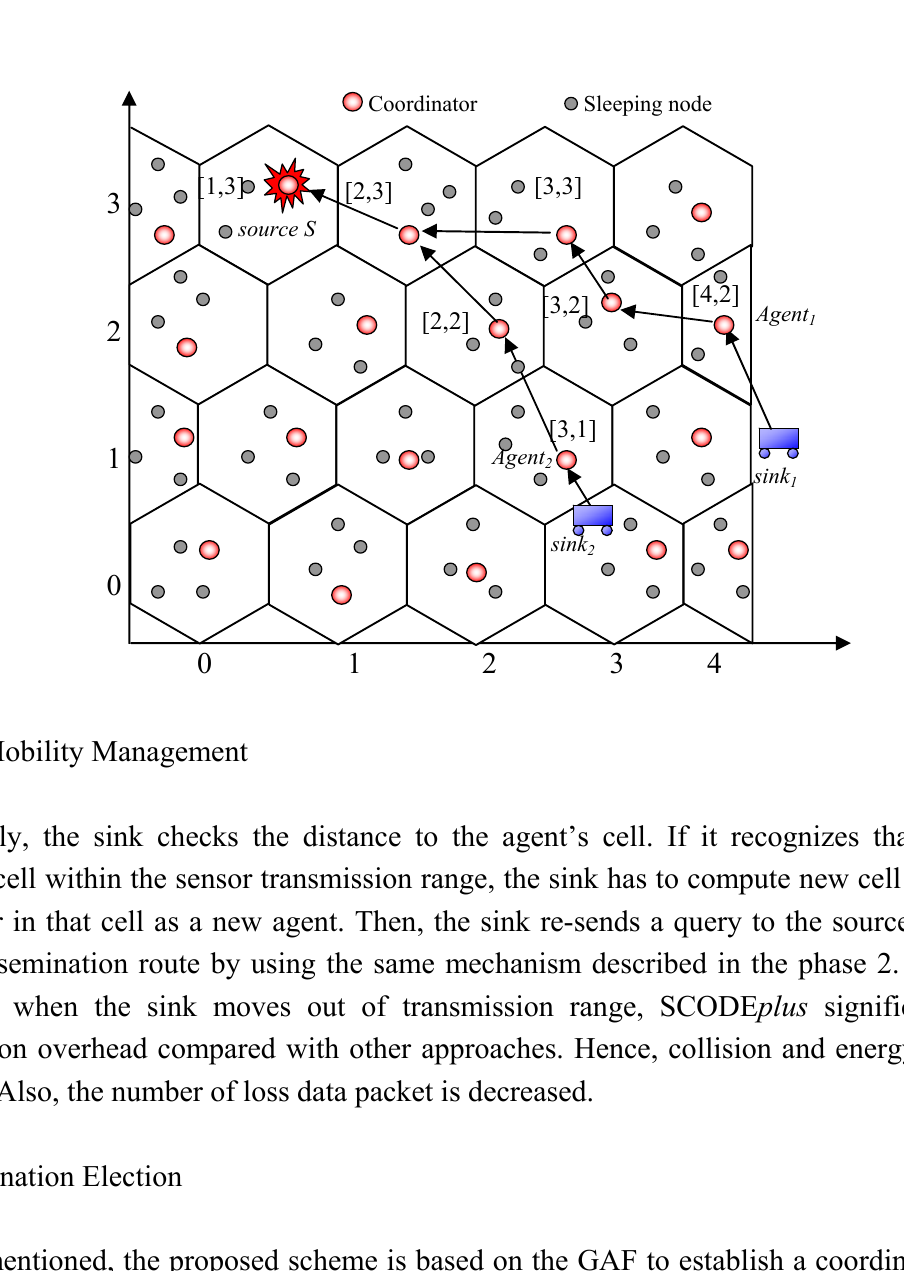
Figure 6. An example of routing in SCODE